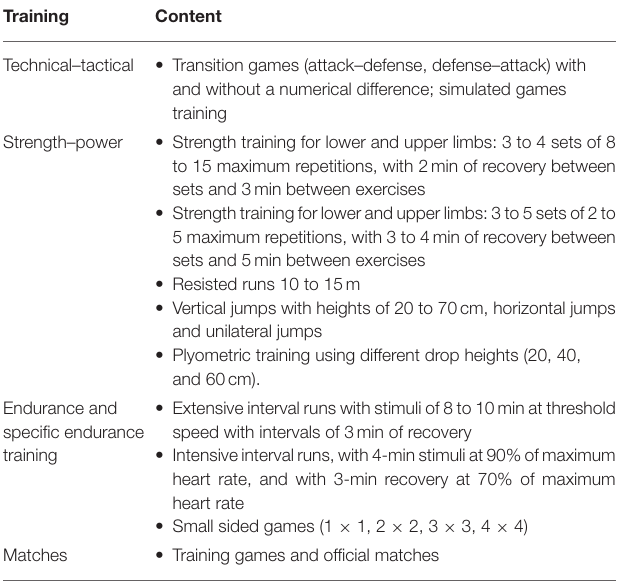
TABLE 1 | Training